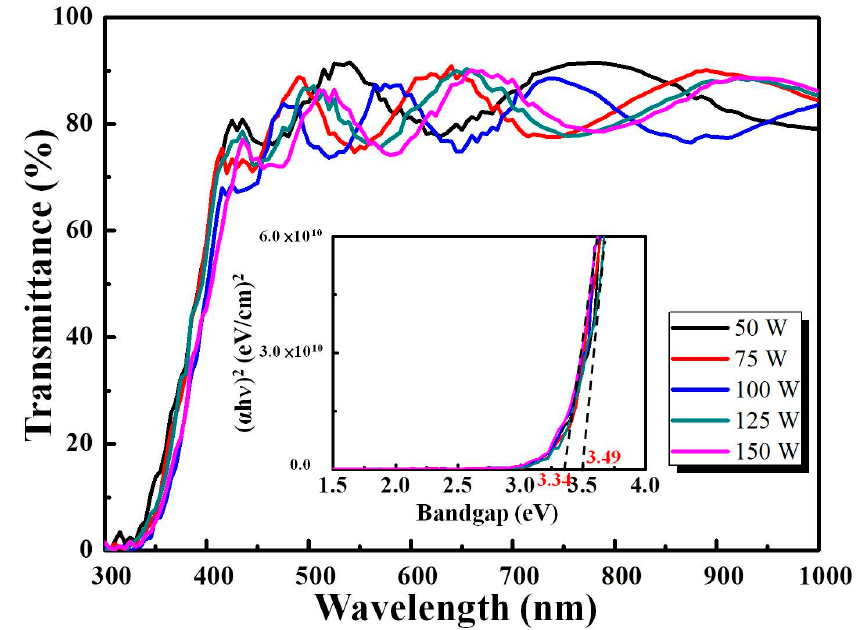
Figure 5. The optical transmittance spectra and band gap of IZTO films with different sputtering powers.